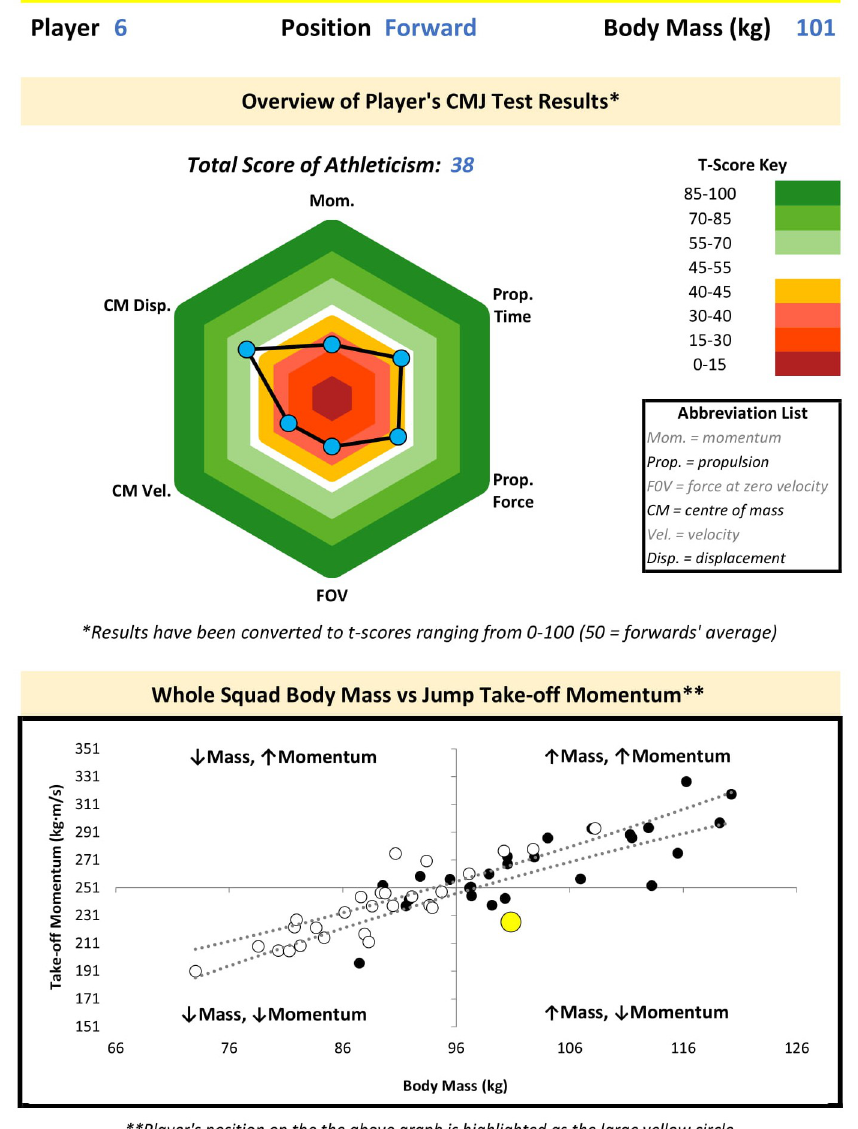
Fig 5. An example one-page report of countermovement jump variables attained by one of the rugby league forwards who participated in this study, alongside the body mass and take-off momentum relationship for the whole rugby league squad via a quadrant scatter chart (per Fig 4). T-scores were calculated using squad median value due to sample size.